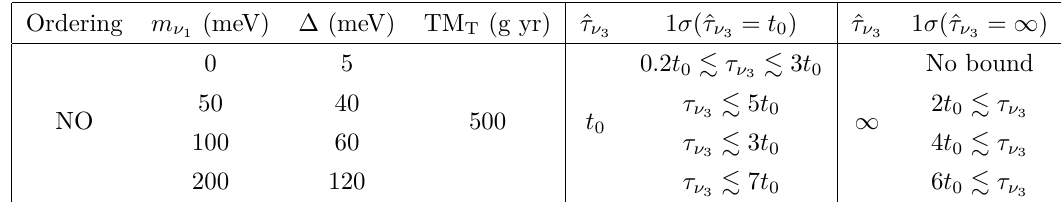
Table 4 . Marginalized constraints on the neutrino lifetime τ ν with fiducial values of ˆ τ = t and ˆ τ = ∞ in the NO case and for various values of the lightest ν 3 0 ν 3 neutrino mass, m , and of the detector resolution, ∆ . We assume an exposure of 500 g yr. ν 1 T and the total mass of tritium M T